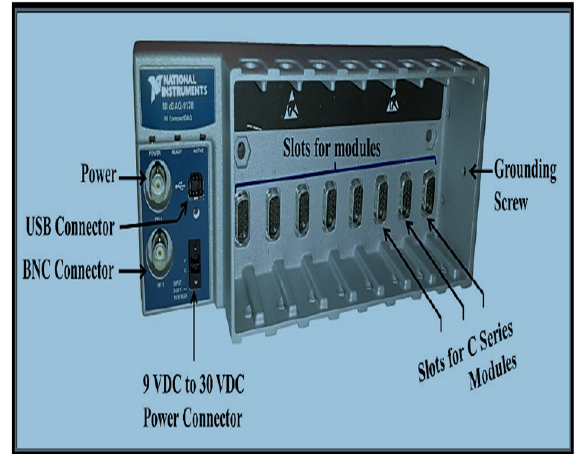
Fig. 4. NI compact DAQ -9178.